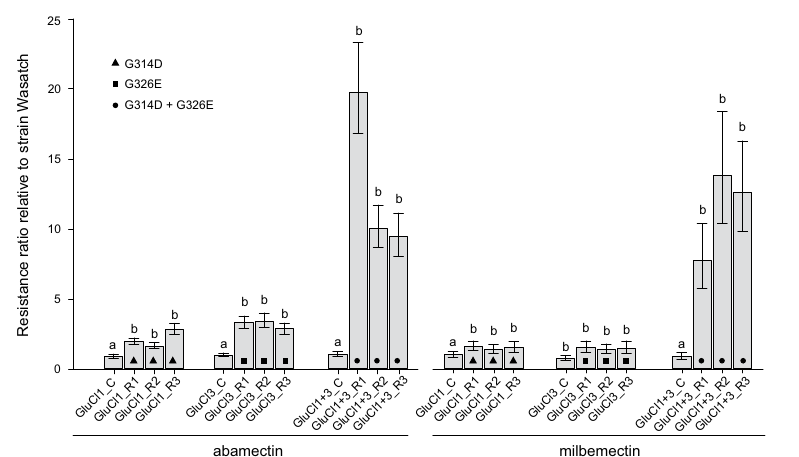
Figure 4. Susceptibility levels of backcrossed T. urticae lines GluCl1_R1-R3 (G314D), GluCl1_C, GluCl3_R1-R3 (G326E), GluCl3_C, GluCl1 + 3_R1-R3 (G314D + G326E), GluCl1 + 3_C to abamectin and milbemectin. The RRs were calculated as the LC 50 values of the backcrossed lines divided by the LC 50 of the parental susceptible strain Wasatch. Error bars represent the 95% confidence limit calculated by probit analysis. Letters above bars indicate lines where acaricide treatment had statistically the same ( a ) or different ( b ) effect comparing to Wasatch (PoloPlus LeOra Software) 49